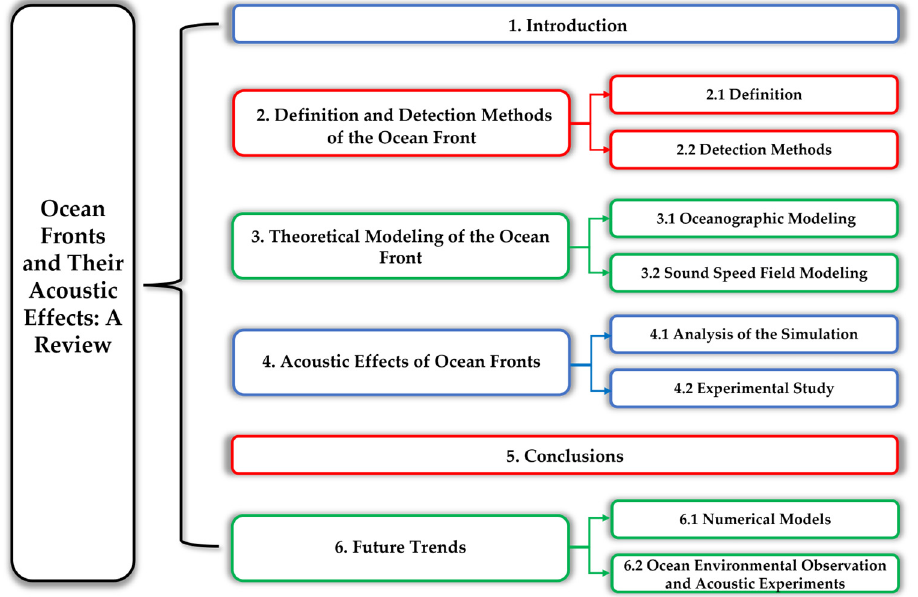
Figure 9. The technical route of the research process.